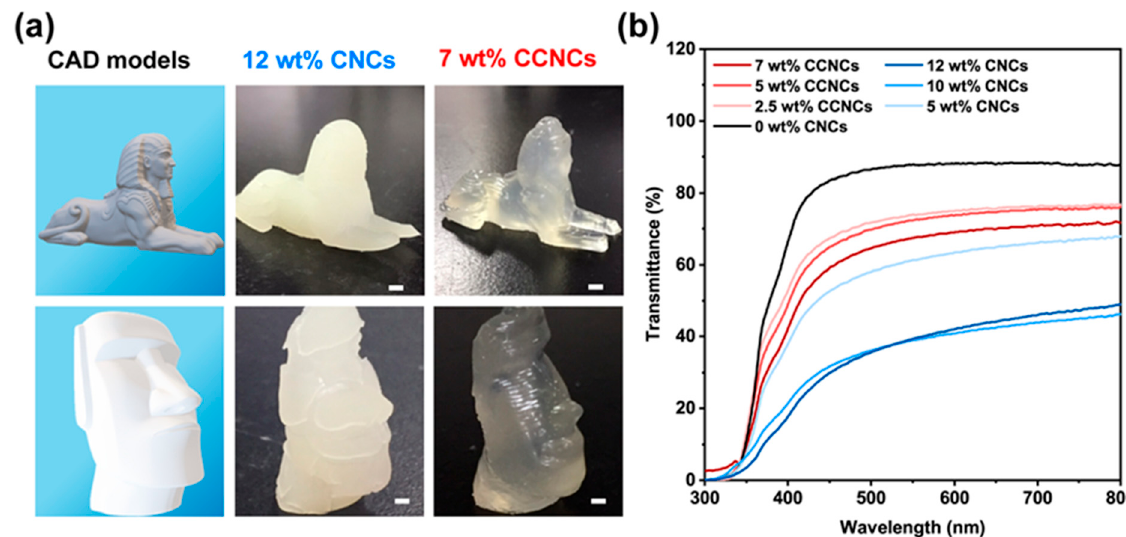
Figure 3. Optical properties and the 3D printed models with different nanocrystal inks. ( a ) 3D printed sphinx and Moai statue. The first column shows the CAD models. The second and third columns show the hydrogels using 12 wt.% CNCs and 7 wt.% CCNCs, respectively. The nozzle diameter was 0.4 mm. The scale bars correspond to 1 cm. ( b ) Transmittance spectra of the printed hydrogel film using various concentrations of CNCs or CCNCs.